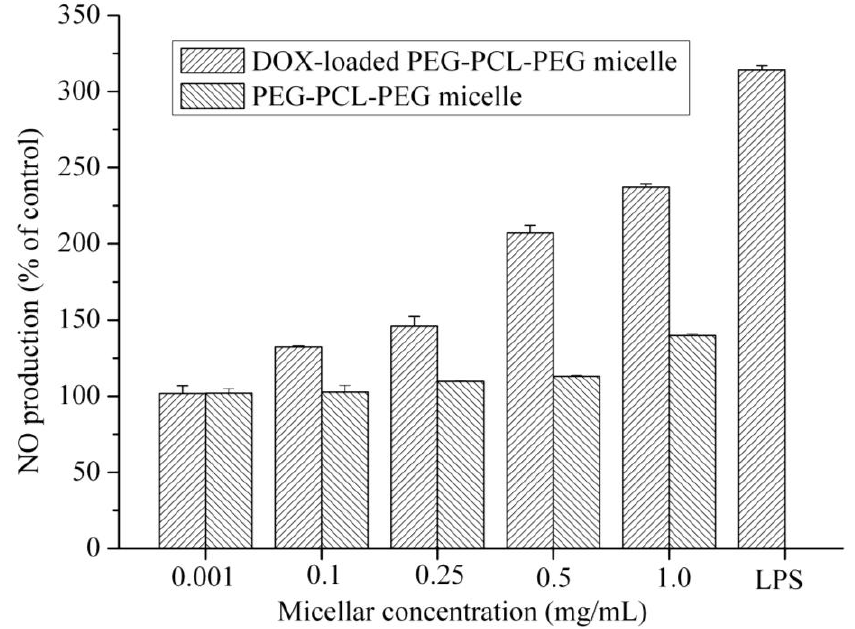
Figure 1. Effects of PEG-PCL-PEG micelle and DOX-loaded PEG-PCL-PEG micelle